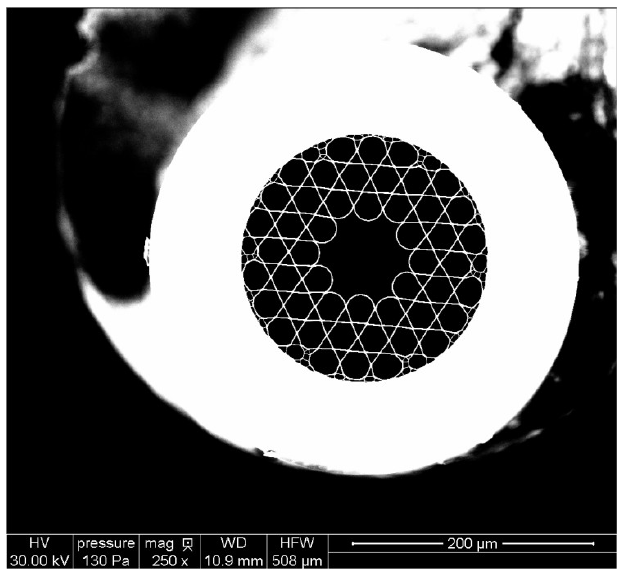
Figure 2. Experimental setup used for fiber